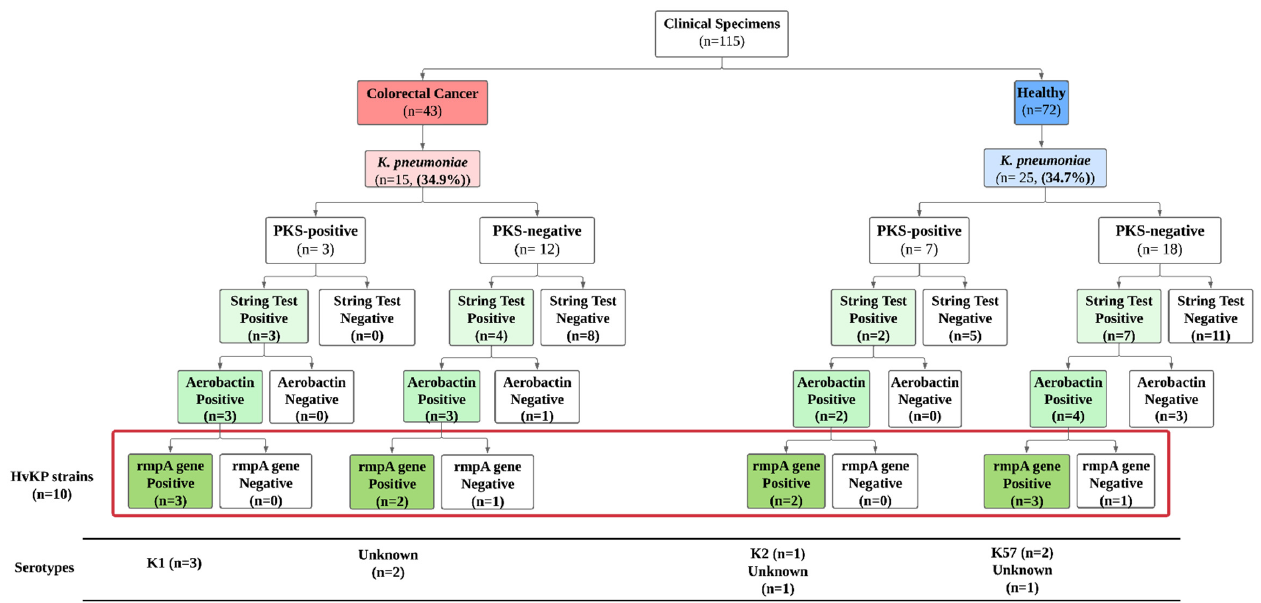
Figure 7: hvKp Strains Serotype and Origin Characteristics Figure 7. hvKp strains serotype and origin